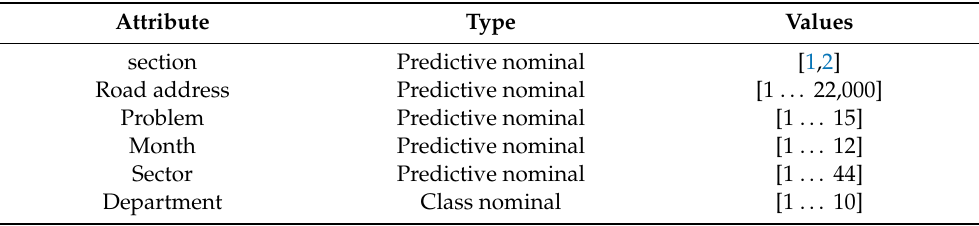
Table 3. Municipality of Papagos–Cholargos dataset description.